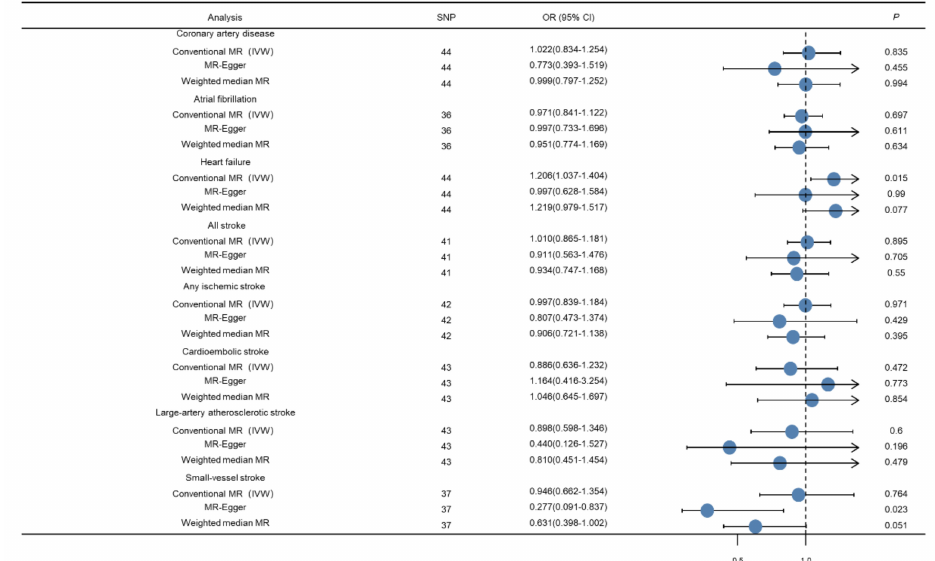
Figure 2. Forest plot depicting MR results for the association of genetically proxied dental caries and periodontitis with cardiovascular diseases.